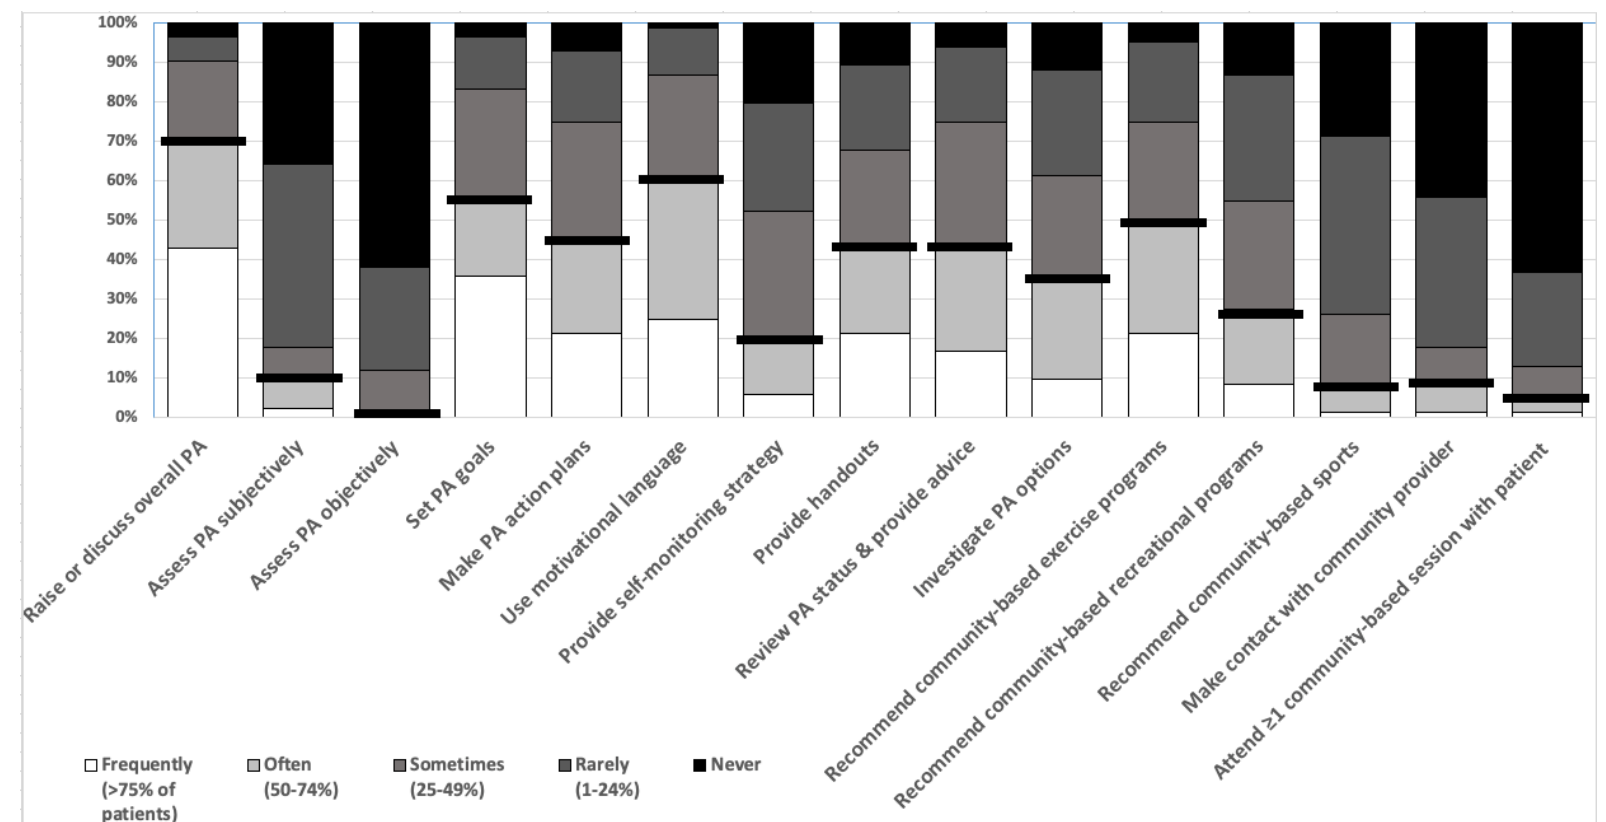
Figure 2. Current PA counselling in routine physiotherapy care. Key: Bold horizontal lines indicate the percentage of physiotherapists who reported providing each physical activity counselling element to more than 50% of patients who the physiotherapists considered could be more active; PA: physical activity.